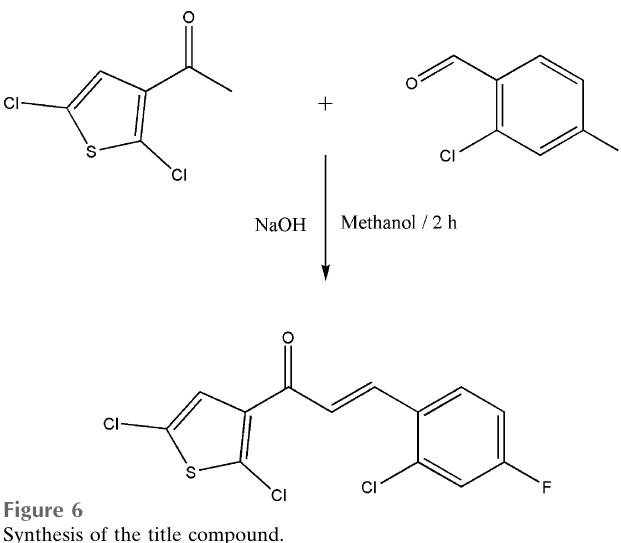
Figure 6 Synthesis of the title compound.